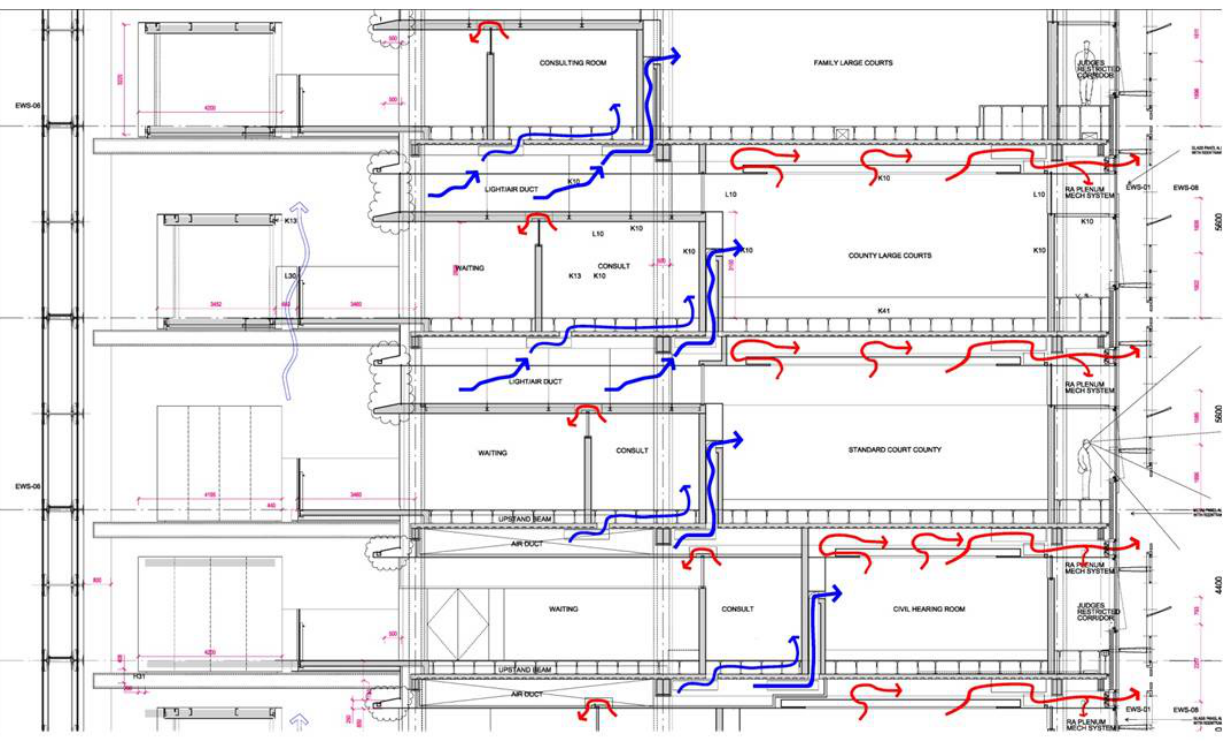
Figure 4. Cross Section showing natural ventilation paths and Light Air Ducts (Blue arrows: Fresh Air In, Red arrows: Exhaust Air).